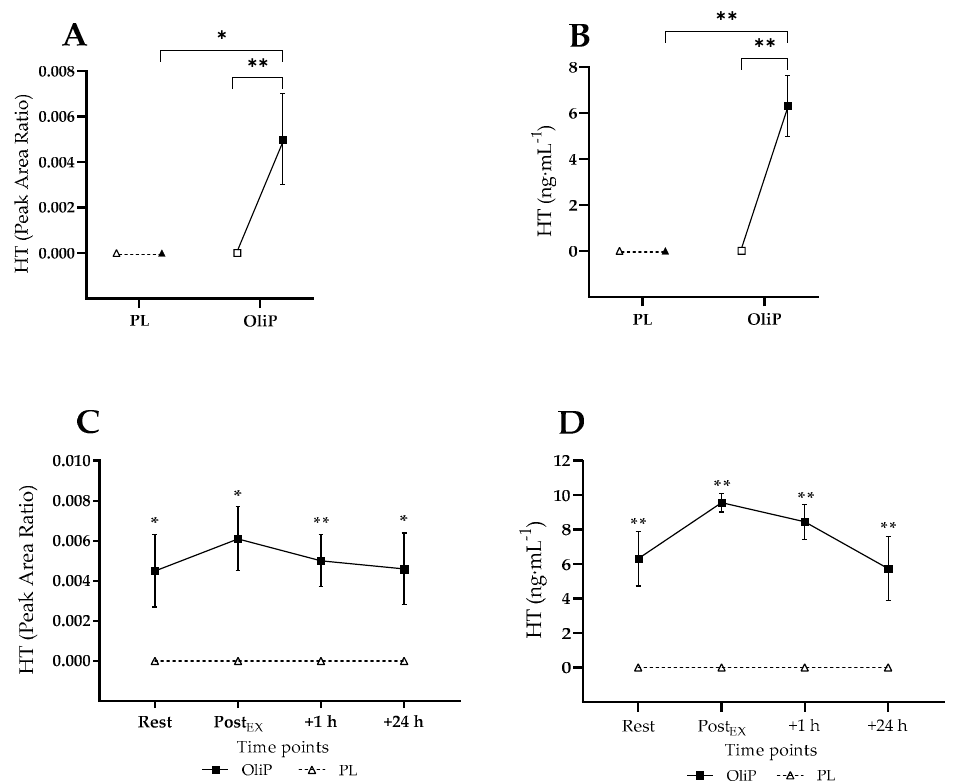
Figure 6. Plasma hydroxytyrosol (HT) responses expressed as instrument peak area ratio ( A , C ) and mean concentration (ng · mL − 1 ; B , D ) in participants that were supplemented with OliPhenolia ® (OliP) for 16 consecutive days or with a matched placebo (PL). ( A , B ) Resting data pre-intervention (open symbols) compared with post-intervention (filled symbols); ( C , D ) Responses post 16-day supplement intervention. Within ( A , B ) * indicates difference between comparative points ( p = 0.029), whereas ** indicates highly significant difference between comparative points ( p ≤ 0.003). Within ( C , D ) * indicates difference between conditions at timepoint ( p ≤ 0.029), ** indicates stronger signifi- cance between conditions at timepoint ( p ≤ 0.004).